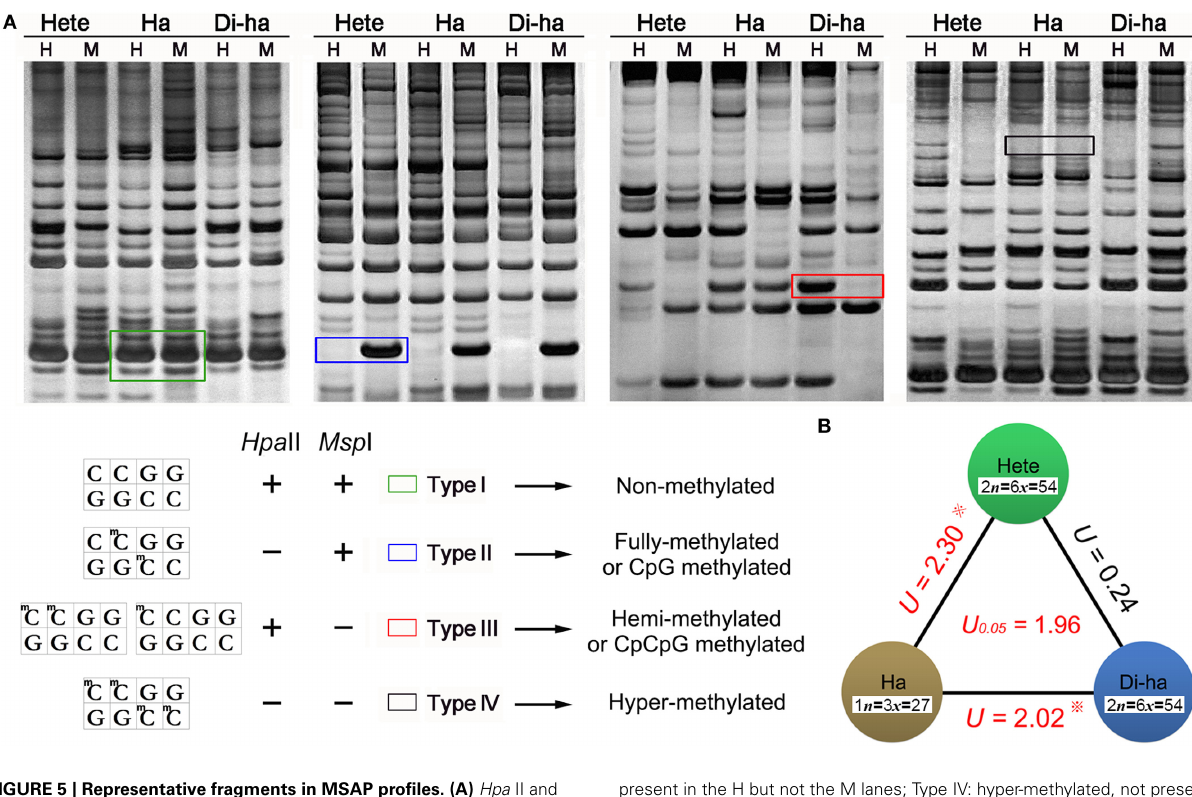
present in the H but not the M lanes; Type IV: hyper-methylated, not present in either the H or M lanes. (B) The U- values within the three forms of chrysanthemum. A higher U -value implies a larger methylation difference between different samples, but only U -value > 1.96 was statistically significant. Hete: cv. “Zhongshanzigui”; Ha: haploid; Di-ha: doubled